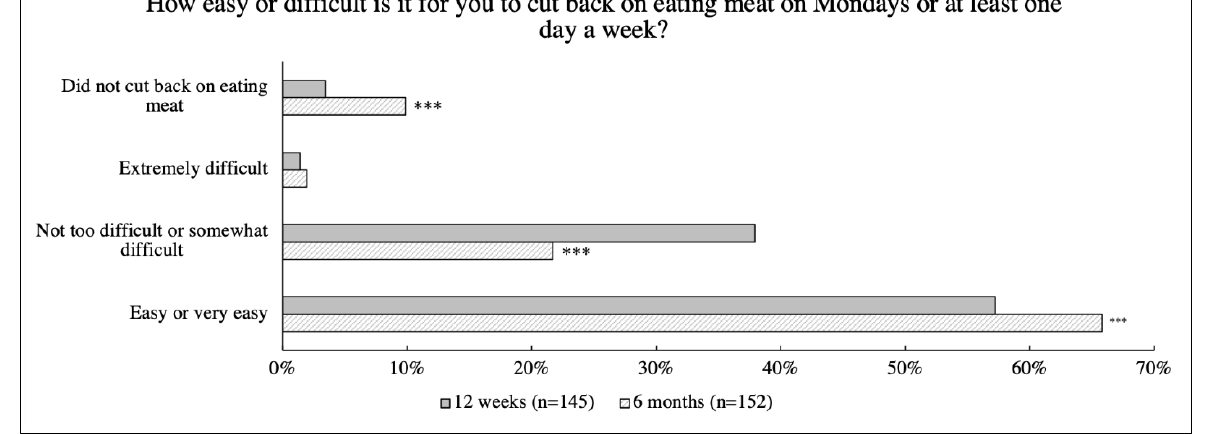
Figure 4. Participants’ Self -Efficacy to Reduce Their Meat Consumption at Least One Day a Week At 12 Weeks and Six-Month Follow